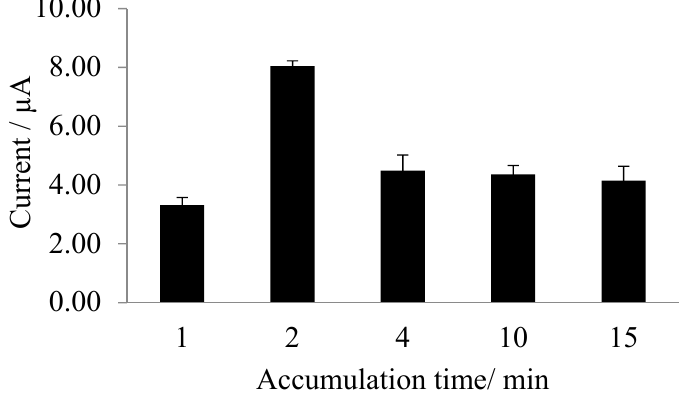
Figure 3. Effects of the exposure time on the oxidation peak current in the presence of 0.5 µ M Tartrazine in 0.1 M PBS pH 5.0. Scan rate: 0.07 V/s. Error bar represents the standard deviation of triple measurements.